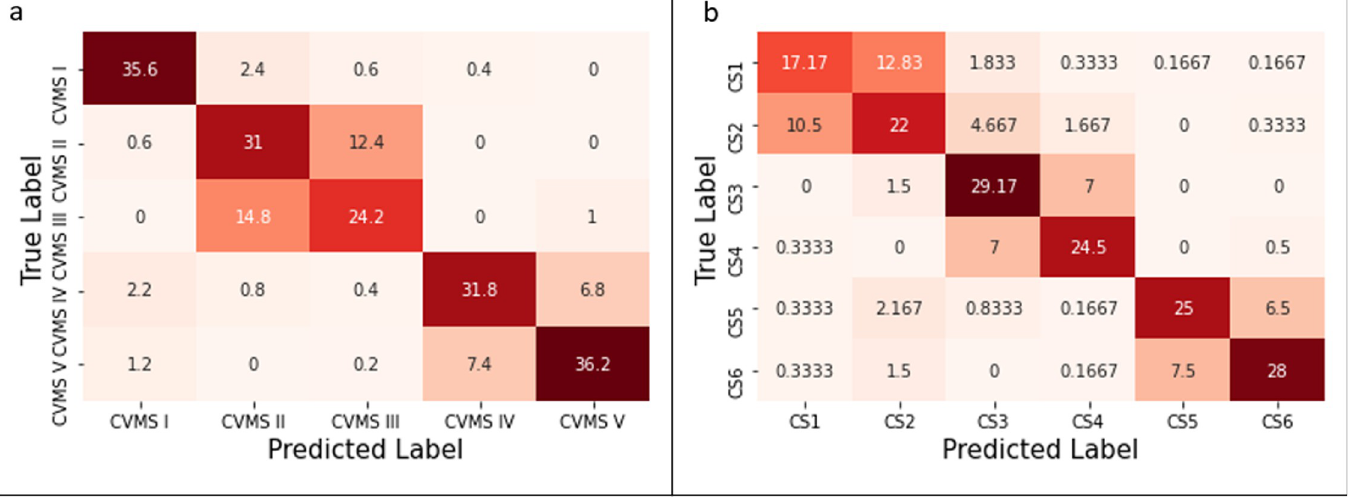
PLOS ONE | https://doi.org/10.1371/journal.pone.0269198 July 1,